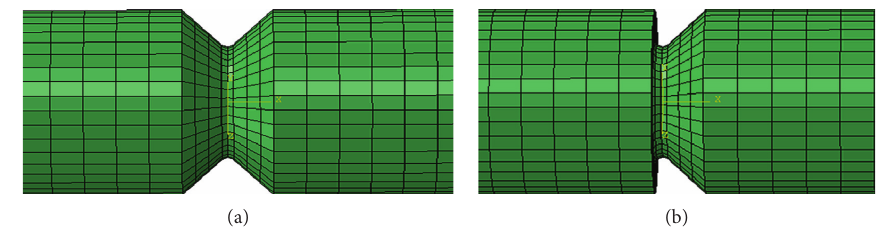
Figure 3: (a) Symmetric notch. (b) Asymmetric notch.